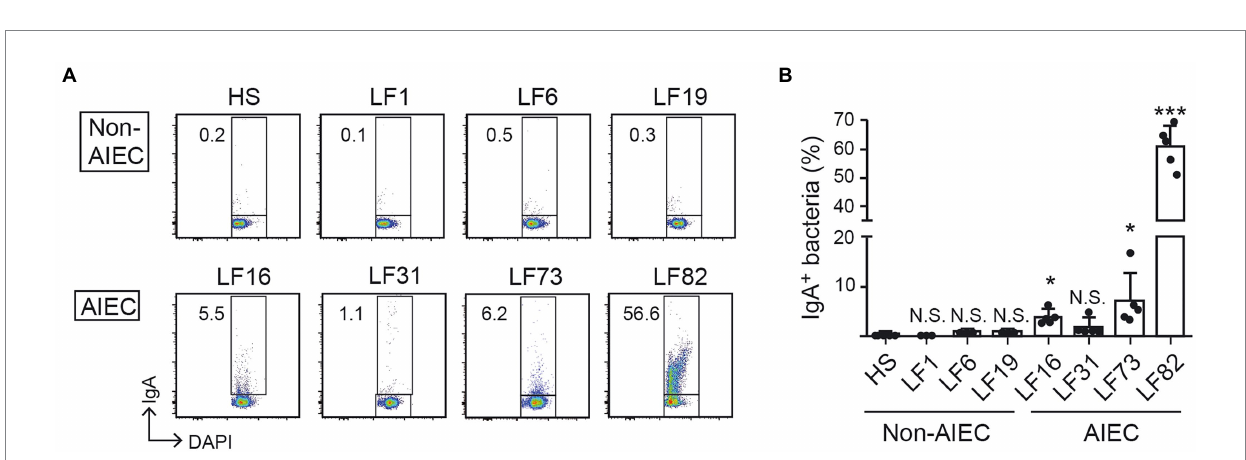
FIGURE 3 AIEC-specific IgA distinguishes AIEC from human commensal bacteria. The IgA of LF82-infected mice 4 w after inoculation was analyzed for its binding ability to several AIEC or non-AIEC strains by flow cytometry. (A) Representative flow cytometry plots and (B) percentages of IgA-bound bacteria. Left bars indicate non-AIEC strains and right bars indicate AIEC strains. Data shown are mean ± SD ( N = 5). N.S., not significant; ***, p < 0.001; *, p < 0.05 by Dunnett’s test (vs.